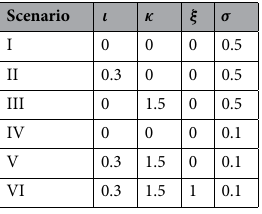
Table 4. Parameters values of the six